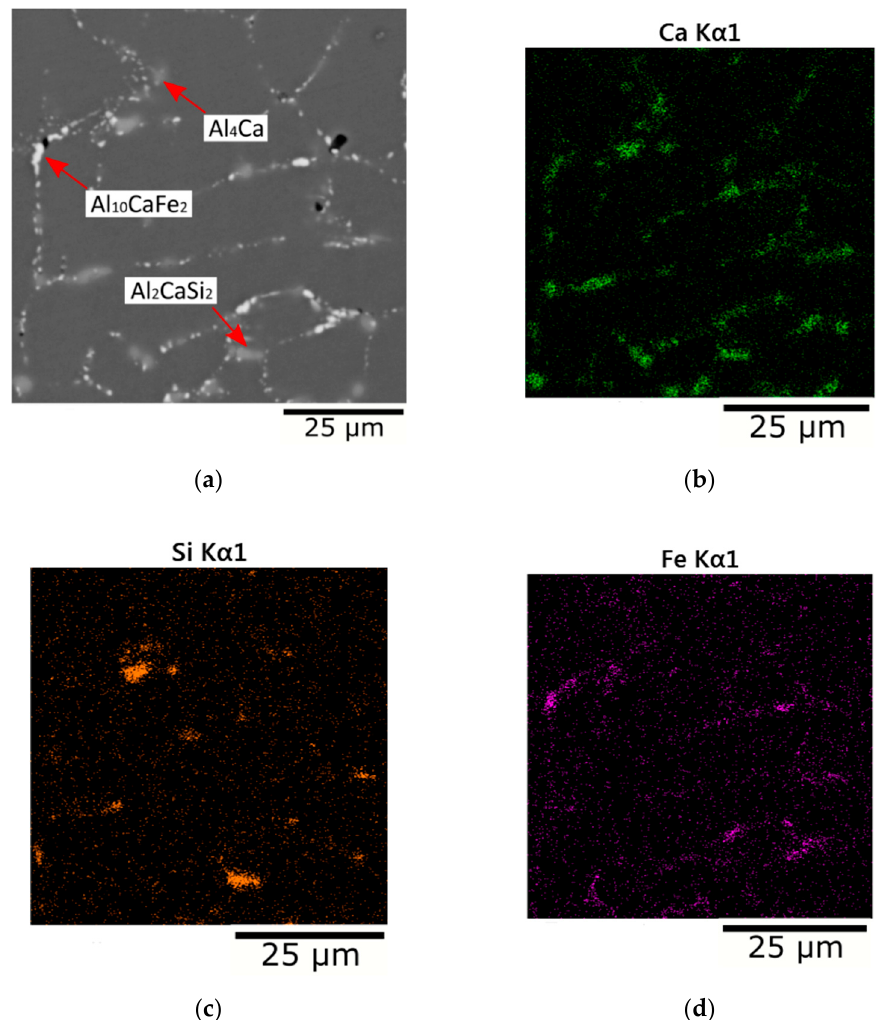
Figure 8. Microstructure of alloy Al-1% Ca-0.5% Fe-0.25% Si (ingot 10 mm × 40 mm × 200 mm) after annealing at 600 °C: ( a ) SEM, ( b – d ) electron microprobe analysis (EMPA) mapping ( b —Ca, c —Si, d —Fe).